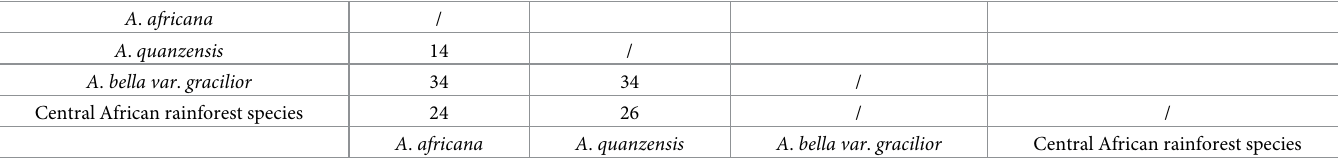
Table 5. SNP variation in the ITS (ITS1 & ITS2) region among Afzelia species. “Central African rainforest species” indicates A . bella var . bella , A . bipindensis and A . pachyloba